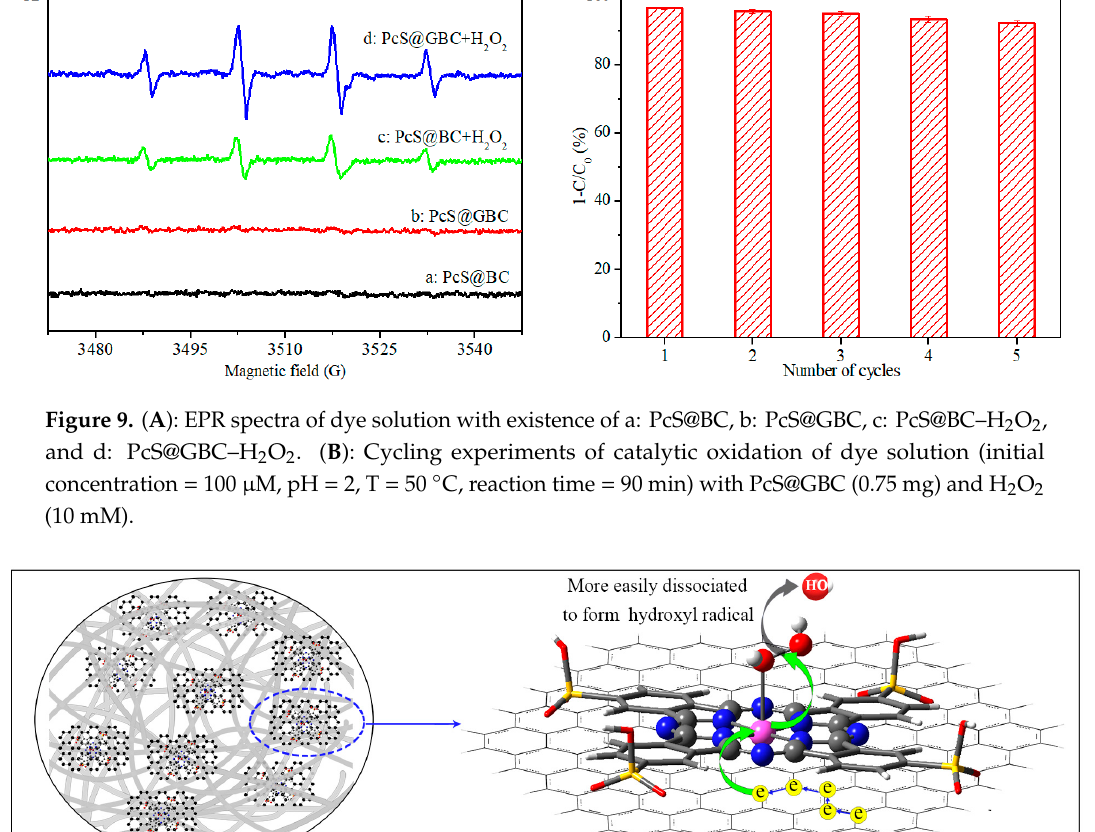
Figure 9. ( A ): EPR spectra of dye solution with existence of a: PcS@BC, b: PcS@GBC, c: PcS@BC–H 2 O 2 , and d: PcS@GBC–H 2 O 2 . ( B ): Cycling experiments of catalytic oxidation of dye solution (initial concentration = 100 μ M, pH = 2, T = 50 ° C, reaction time = 90 min) with PcS@GBC (0.75 mg) and H 2 O 2 (10 mM).